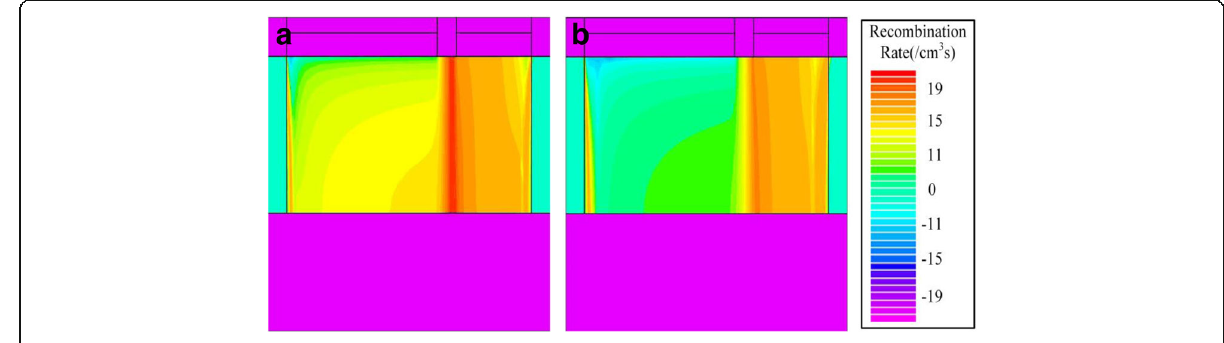
Fig. 9 Recombination rate of a S/S/S and b S/S/H after reading “ 0 ”